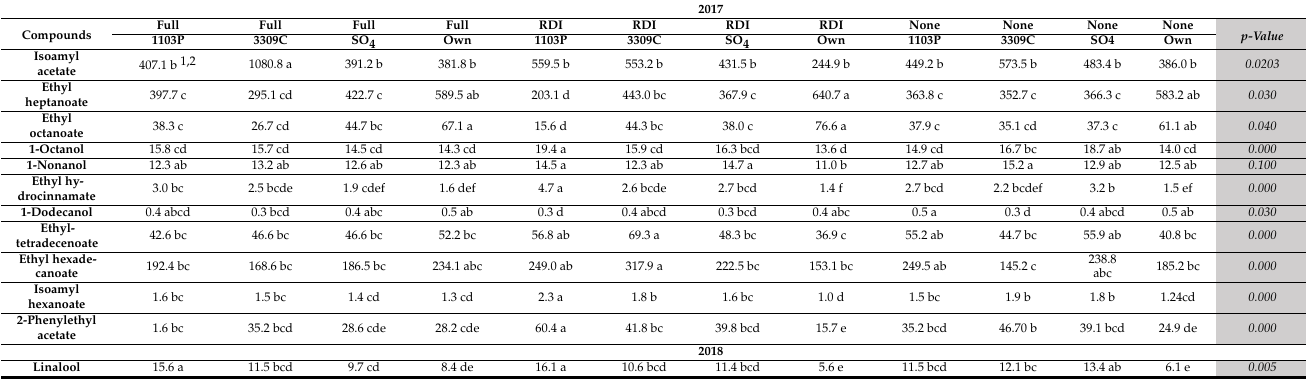
Table 1. Mean concentrations of wine volatiles in 2017 and 2018 between rootstocks and irrigation.